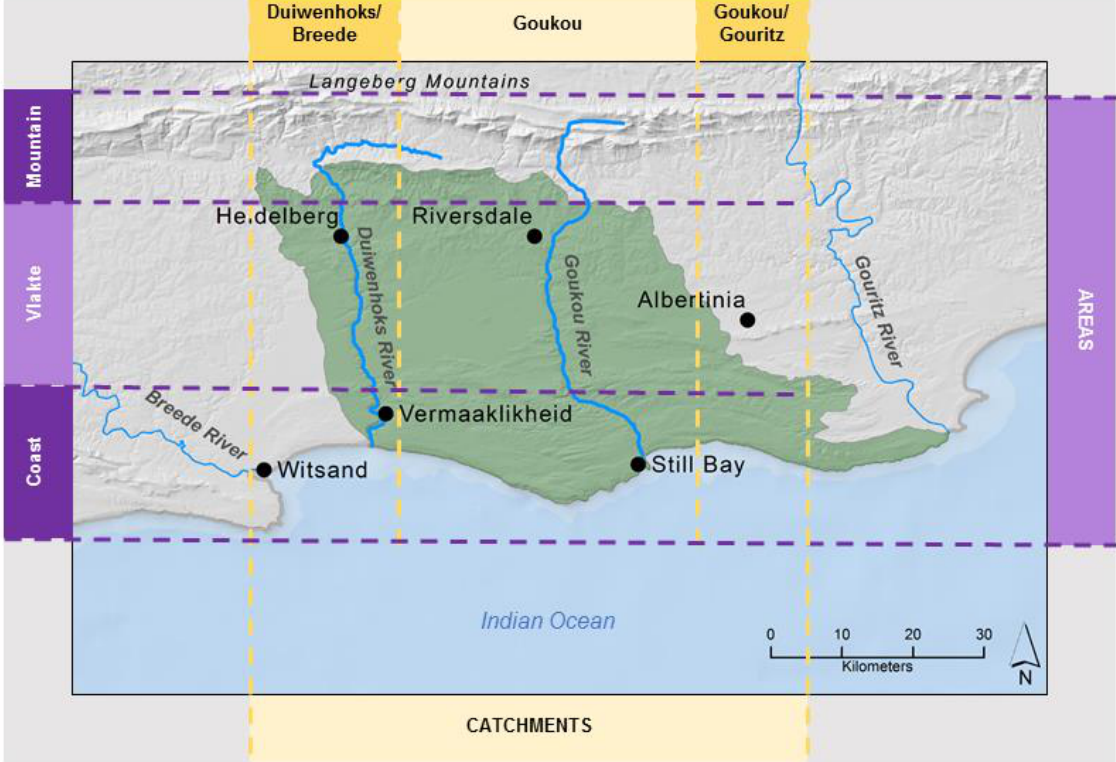
Figure A1.1: Different catchment and area groupings across the research area as a reference for